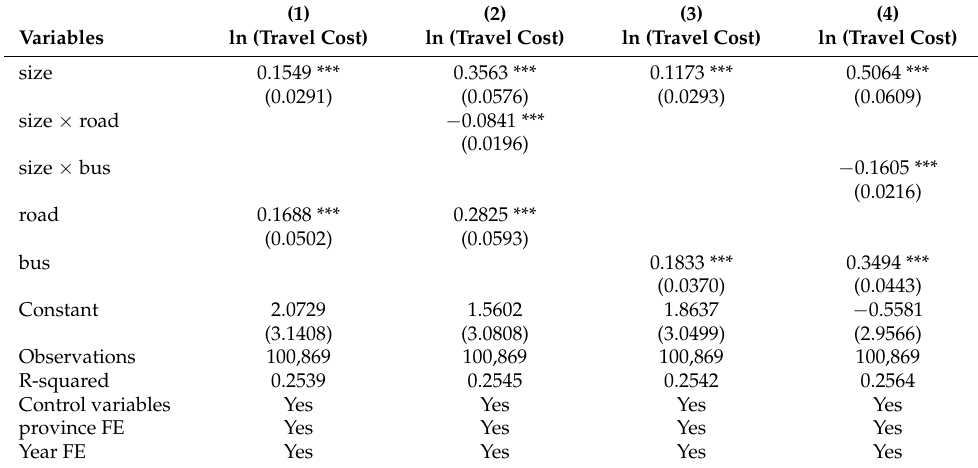
Table 6. The regression results for the moderating